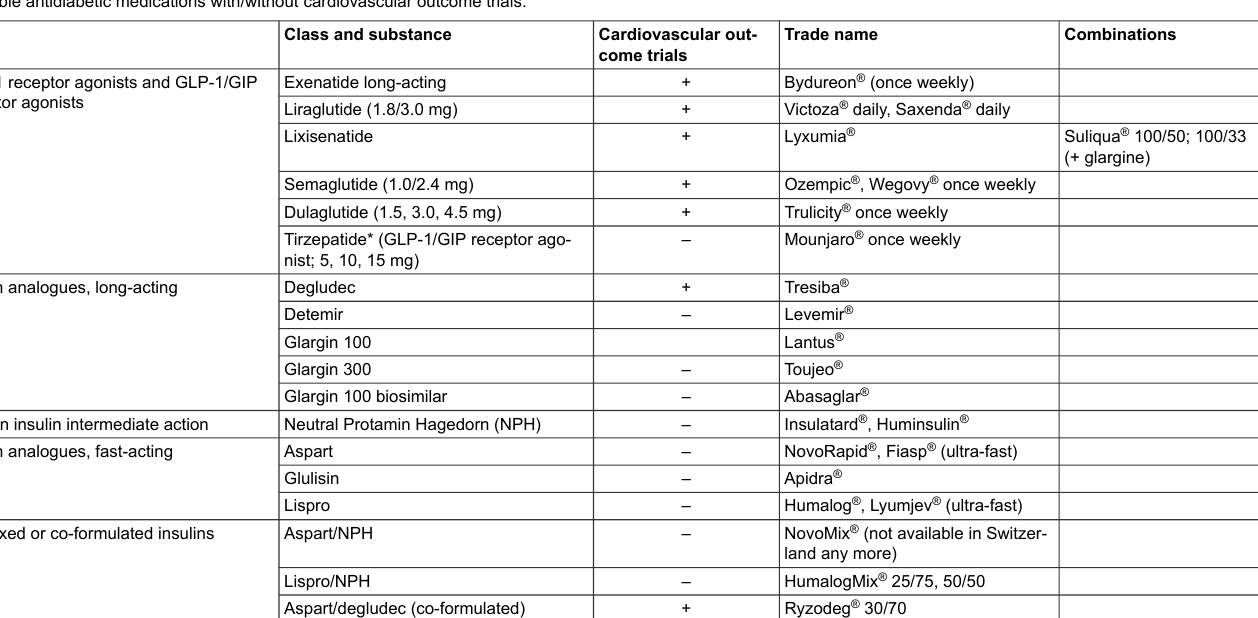
Table 5: Injectable antidiabetic medications with/without cardiovascular outcome trials.